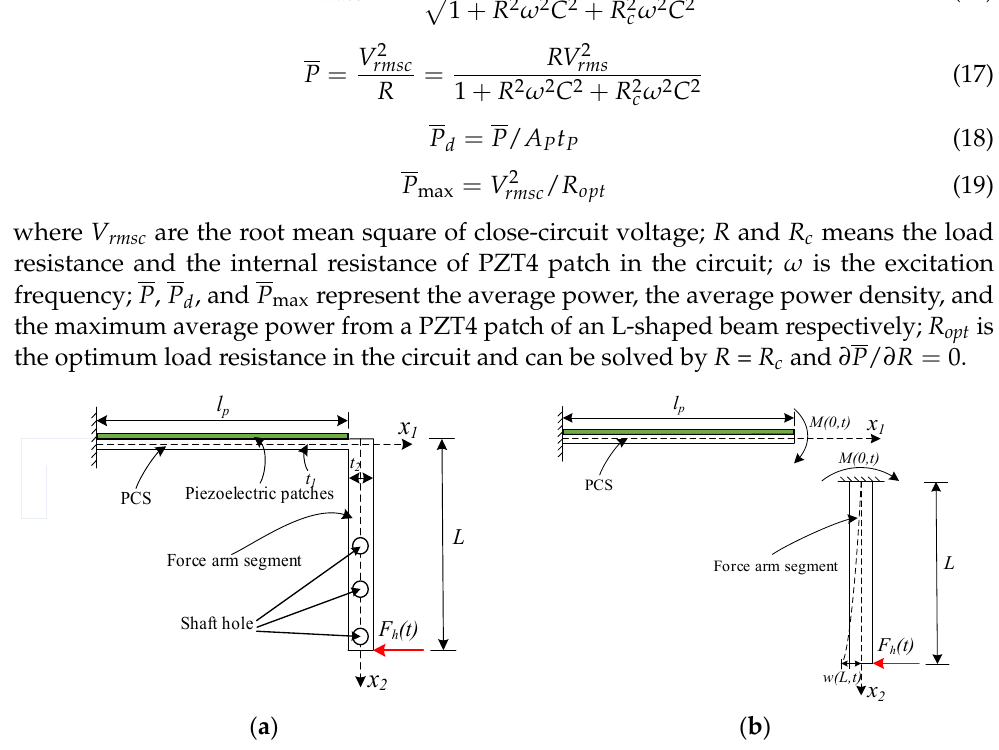
Figure 6. The physical model of LPCB of 1 # piezoelectric brick. ( a ) Model of LPCB; ( b ) Simplified model of LPCB.